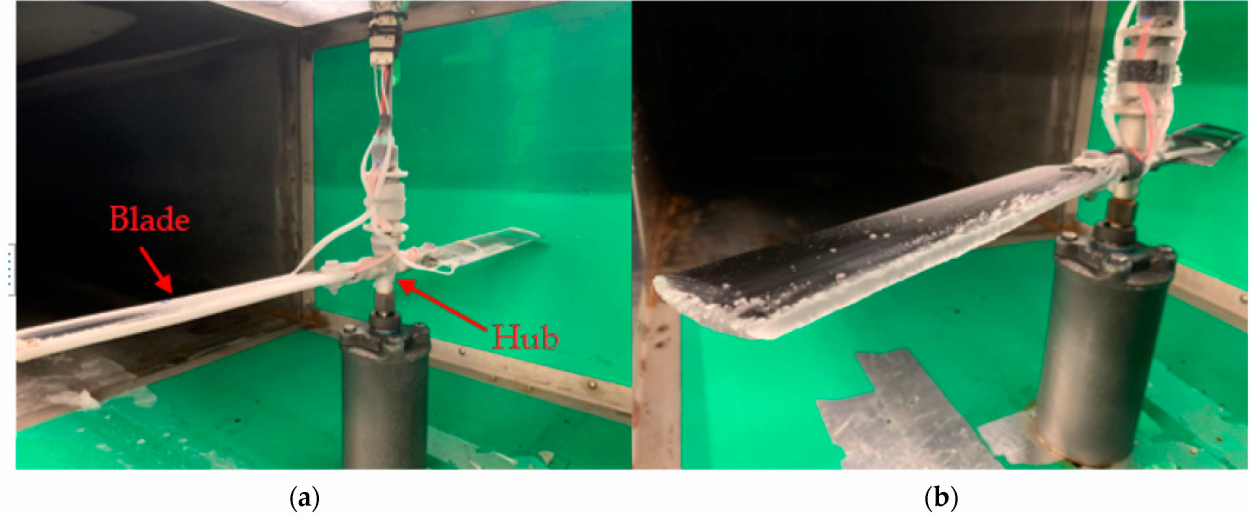
Figure 4. P-SRB Setup ( a ) with aluminum and ( b ) with Coating 3.